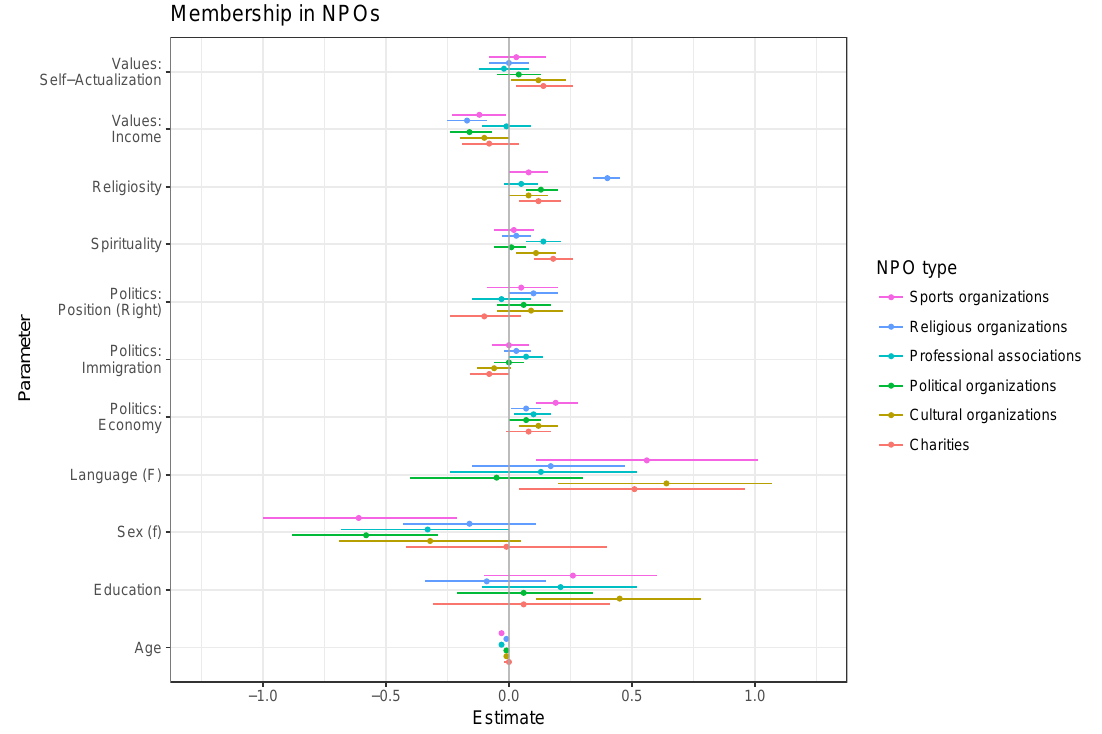
Figure 2. Parameter estimates for the six models with interest in becoming a member of an NPO as the response (dependent)